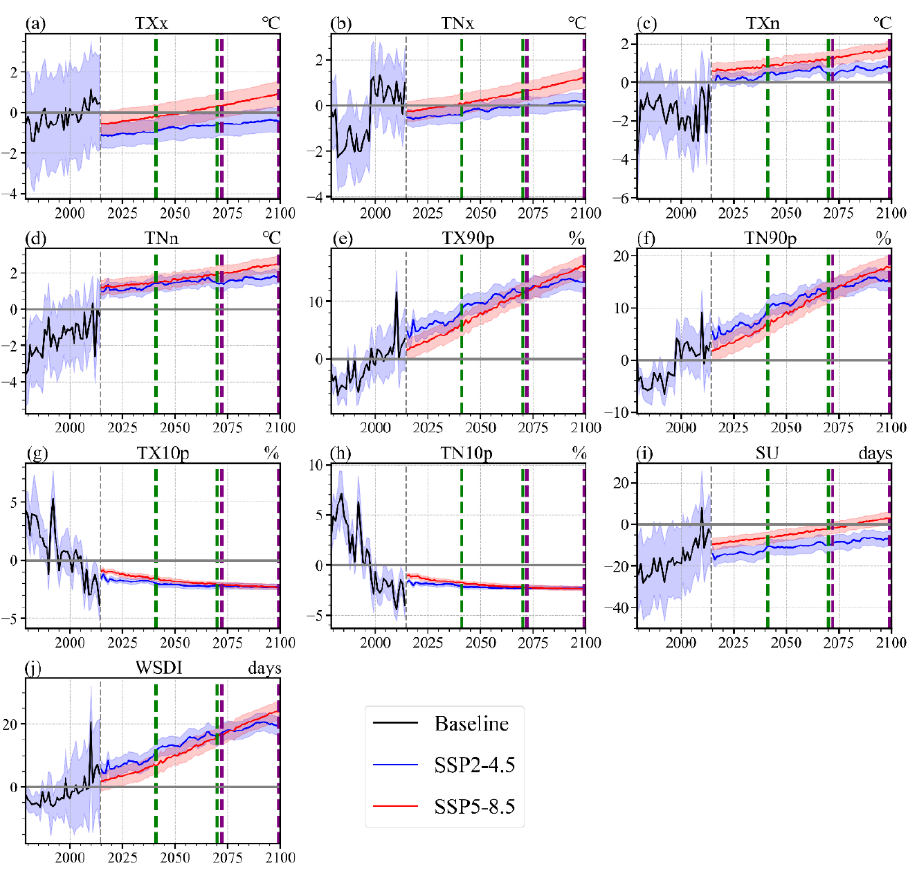
Figure 10. Time series of projected extreme temperature anomalies spatially averaged over the study domain for SSP2-4.5 (blue) and SSP5-8.5 scenario (red). The anomaly is calculated relative to the mean of baseline period. The green and purple dotted lines indicate the mid- (2041–2070) and far-future period (2071–2100), respectively. The blue and red shadings are the corresponding model spread about the MME.